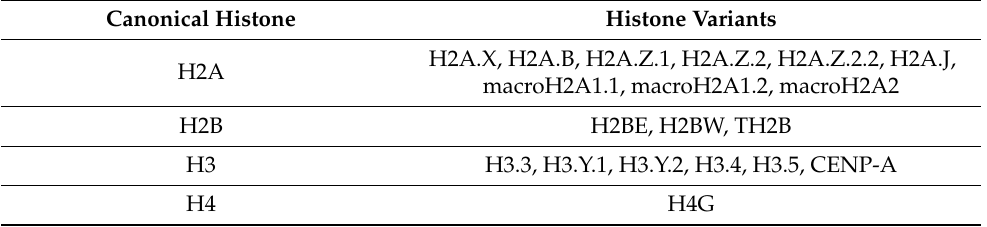
Table 1. Replication-coupled core histones and their variants in